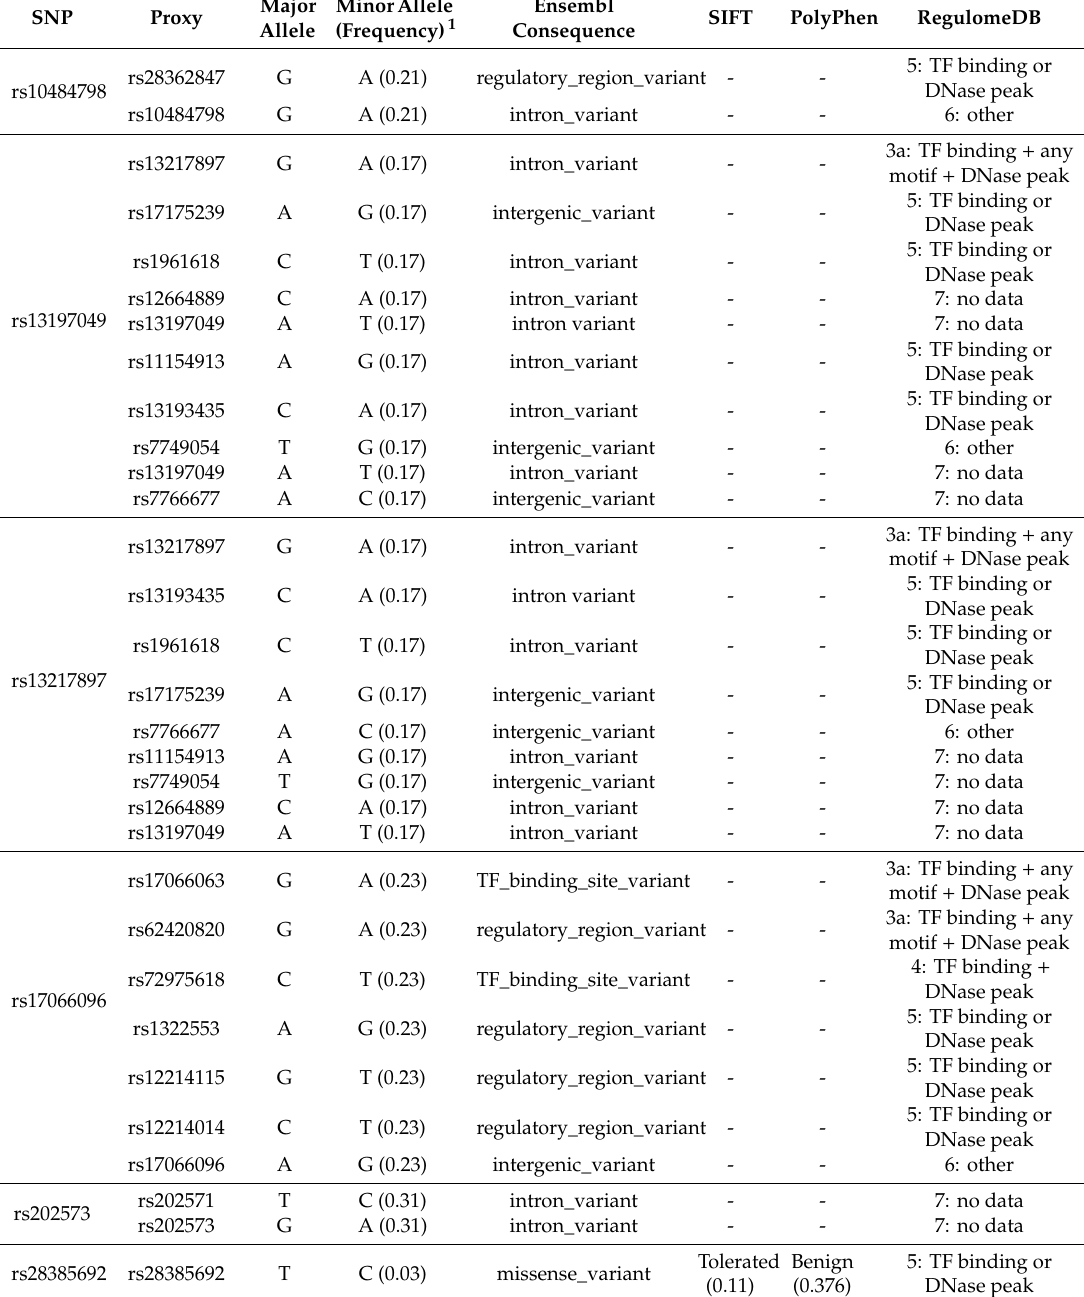
Table 4. Functional predictions of associated SNPs and proxies. SNPs with significant associations in the mapping exercise or in the discovery + validation cohorts and their proxies ( r 2 > 0.8 in 1000 Genomes Phase III CEU population) were assessed using VEP and RegulomeDB. 1 Minor allele frequency is based on European populations in the 1000 Genomes Project Phase